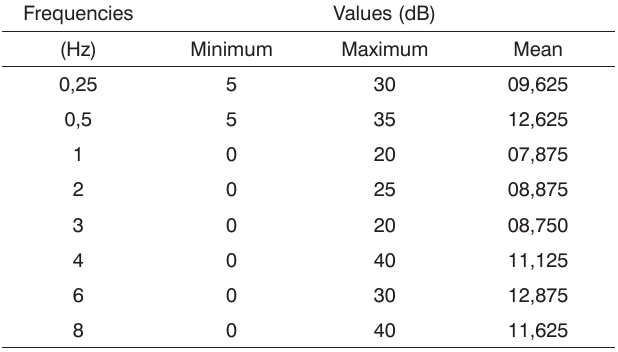
Table 1. Distribution of minimum, maximum, and mean audio- metric threshold values at each frequency for 40 tested ears.